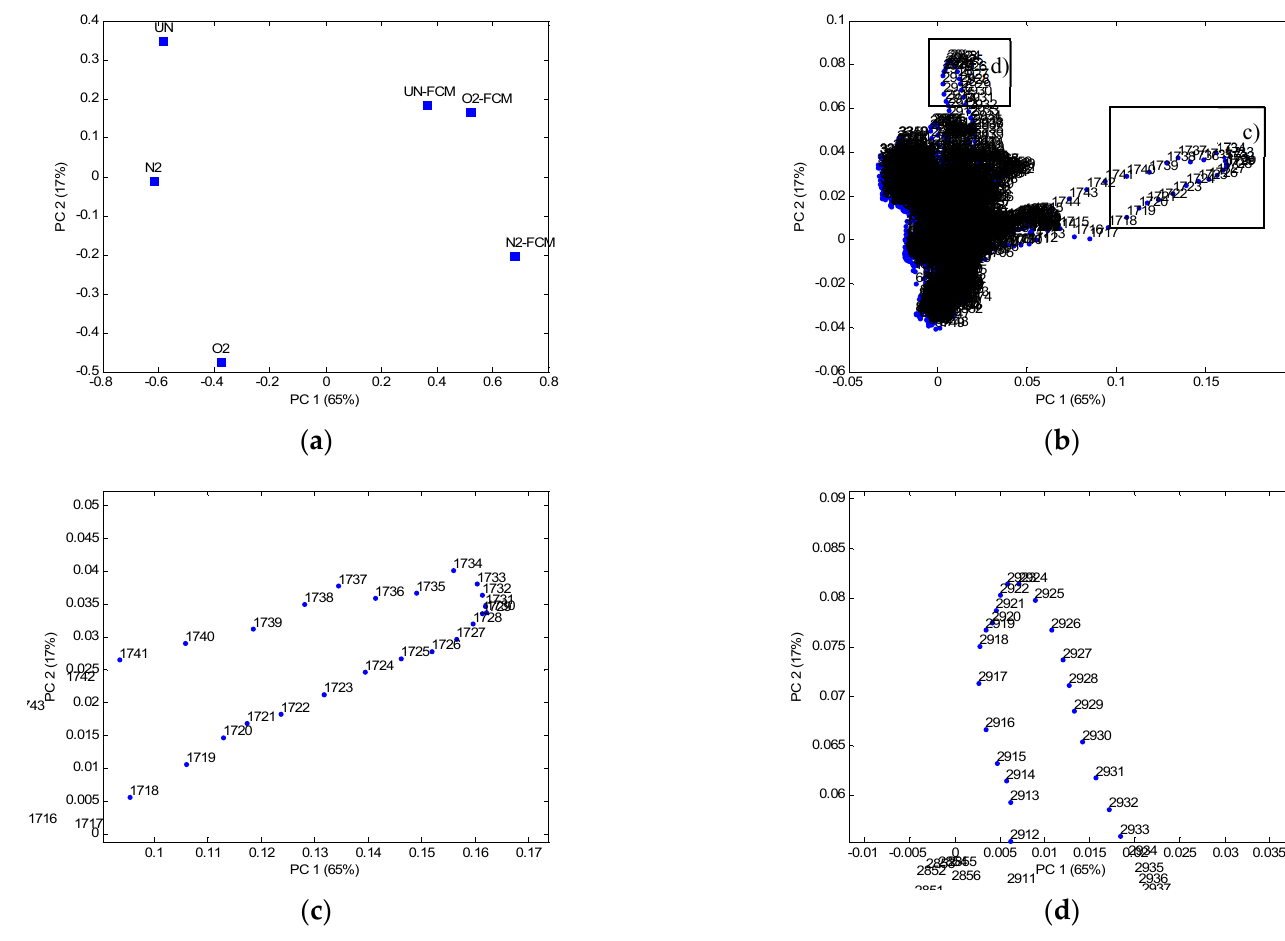
Figure 8. PC1-PC2 score plot ( a ) and PC1-PC2 loading plots ( b – d ).